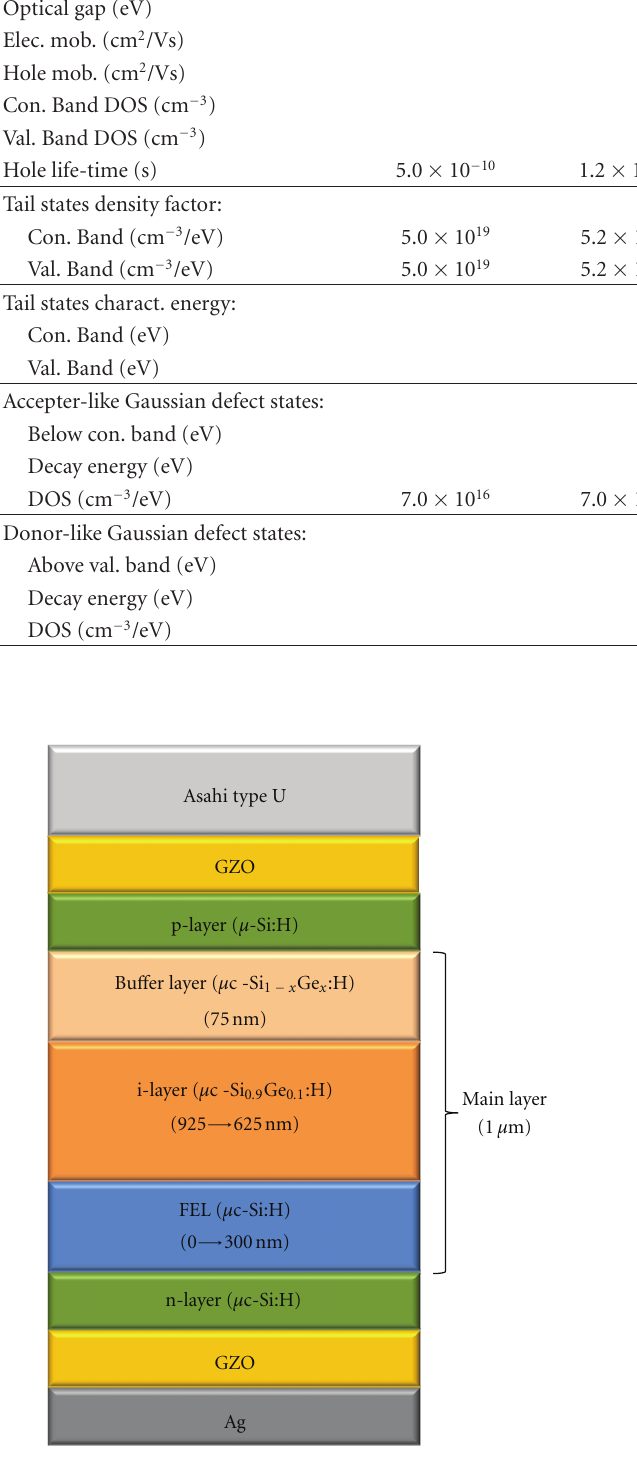
Figure 1: Schematic diagram of the μ c-Si 0 . 9 Ge 0 . 1 :H p-i-n solar cell with the graded μ c-Si 1 − x Ge x :H bu ff er layer and μ c-Si:H